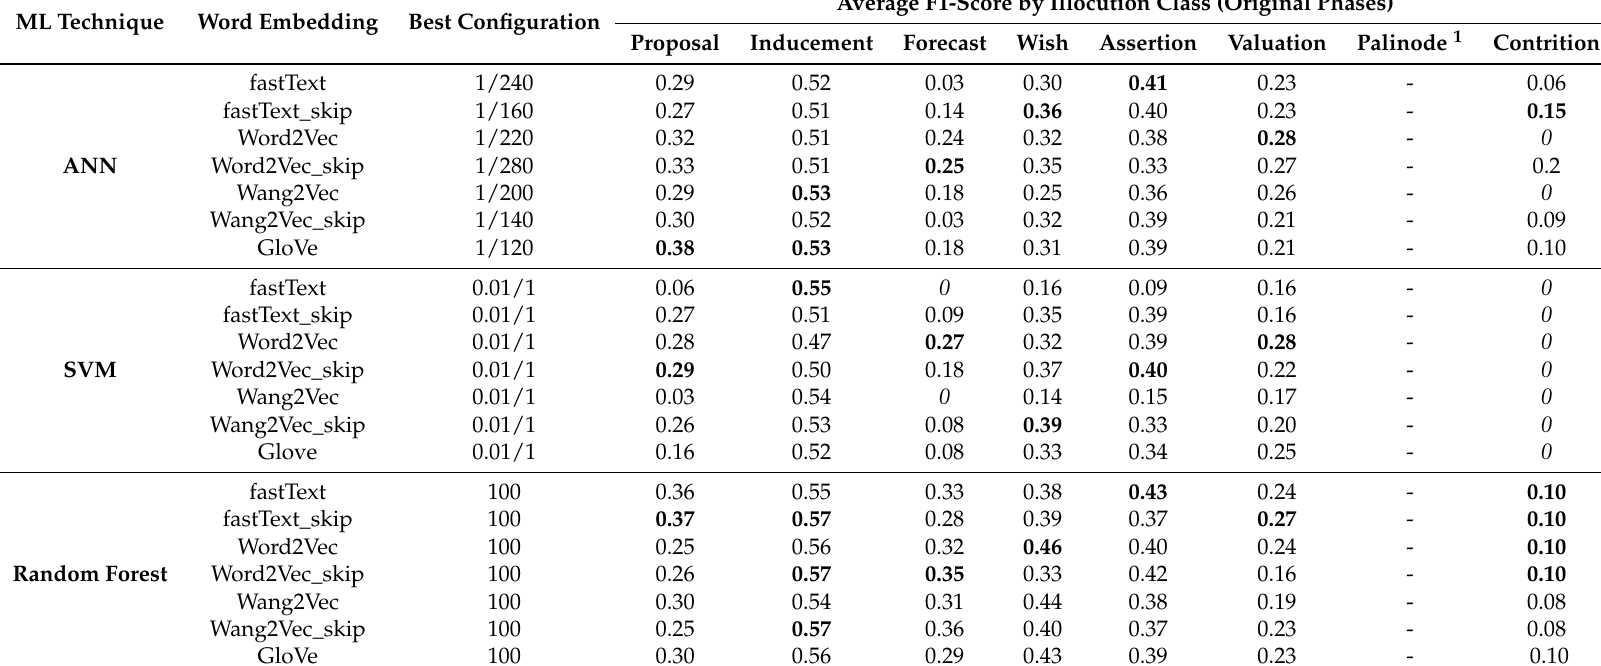
Table 4. Experimental results obtained with the ANN, SVM, and Random Forest classifiers with the Original Phases. Word embedding vector dimension: 600. Cross-validation method with k = 5. Average F1-score by illocution